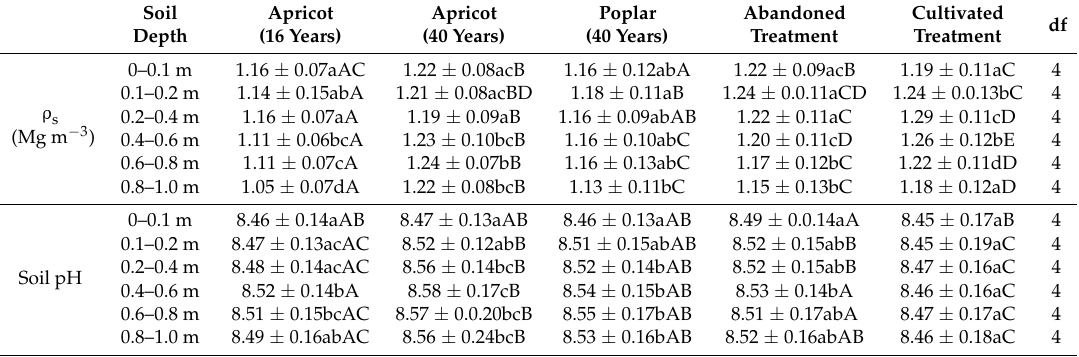
Table 3. Soil bulk density ( ρ s ) and pH changes in different soil layers under different treatments. (mean ± standard